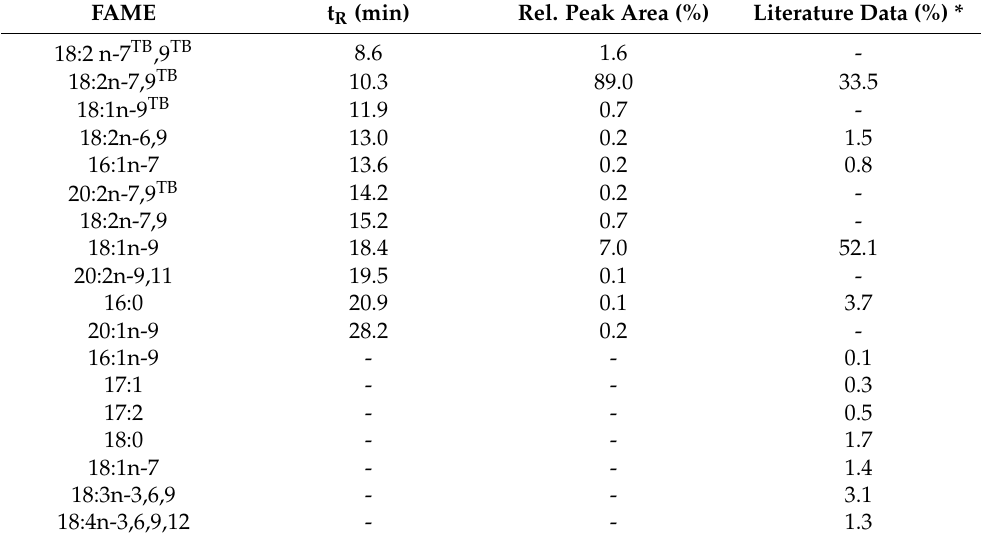
Table 5. FAMEs identified in TG fraction of S. album seed